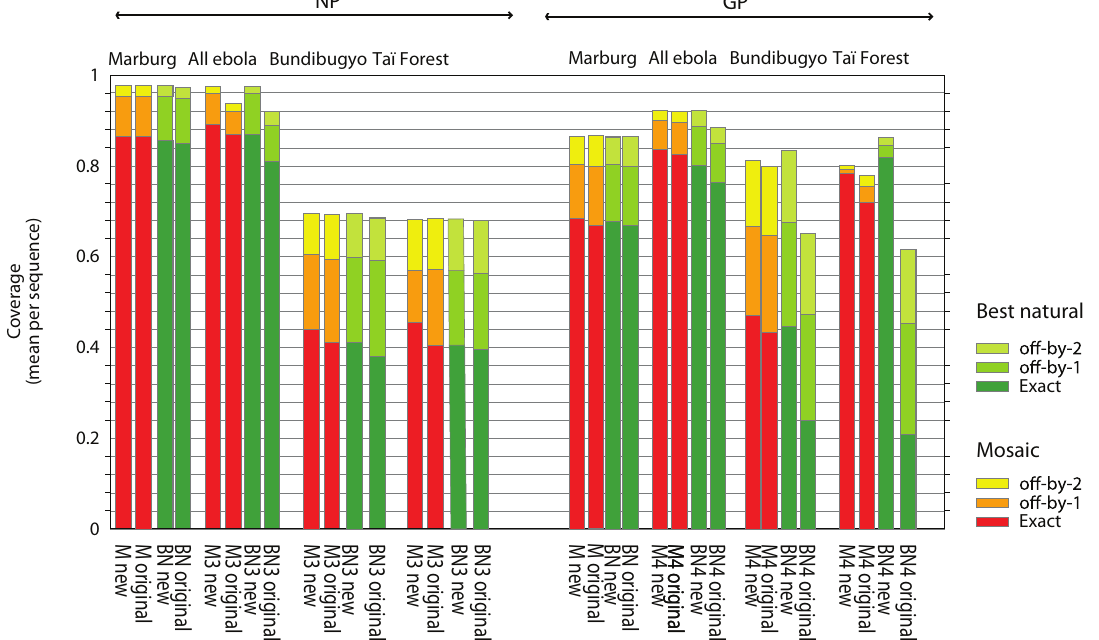
Figure 2. Coverage robustness. The coverage of new protein set viral diversity of nucleoprotein (NP) and glycoprotein (GP) by vaccines designed against original and new protein sequence sets for both mosaic cocktails and best-natural cocktails. Comparisons are shown of Marburgvirus and Ebolavirus genera, and of Bundibugyo ebolavirus and Tai Forest ebolavirus species.